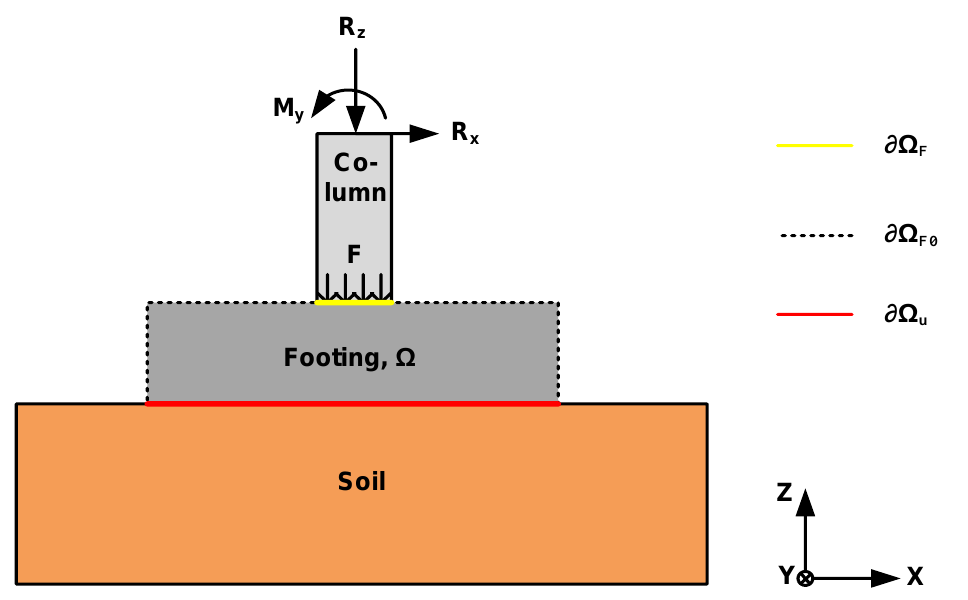
Figure 2. Shallow footing fixed at the surface of